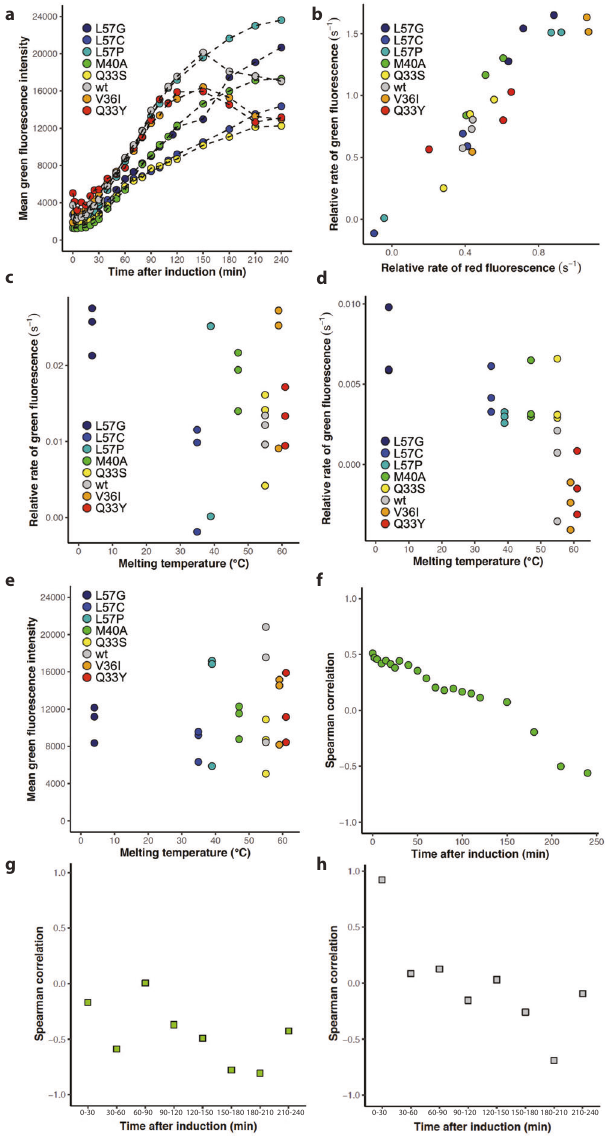
Expression from the DnaK promoter is impacted by protein translation rates and thermostability . Protein folding stress triggers the PQC network and we wished to investigate whether protein translation alone can trigger a response and to what extent the biophysical properties, such as thermostability, of a protein, impact the stress response.